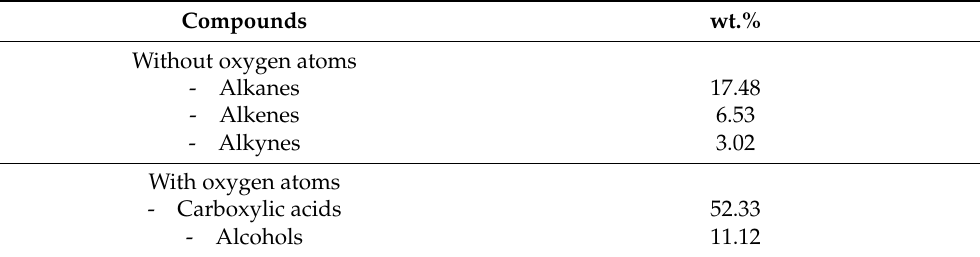
Table 4. The group of organic compounds investigated by the GC–MS analysis of liquid bio-oil.